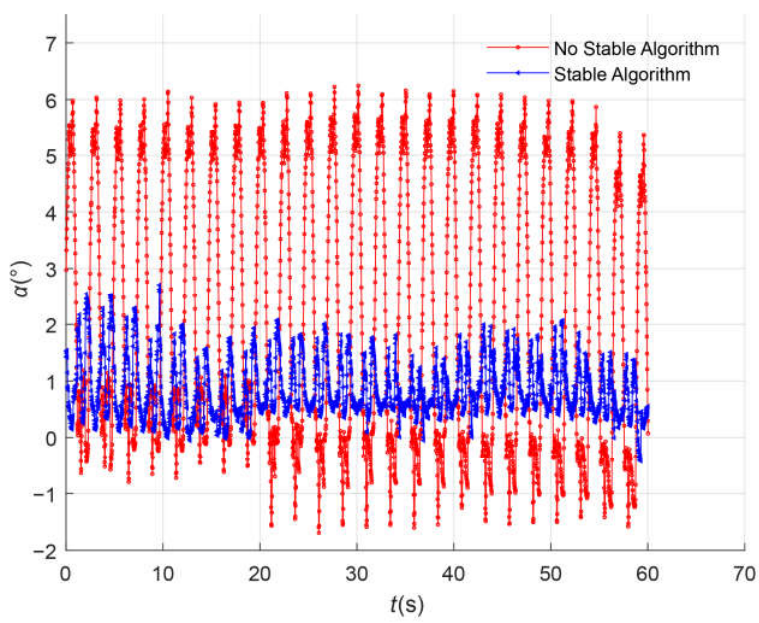
Figure 16. Head stabilization experimental data.